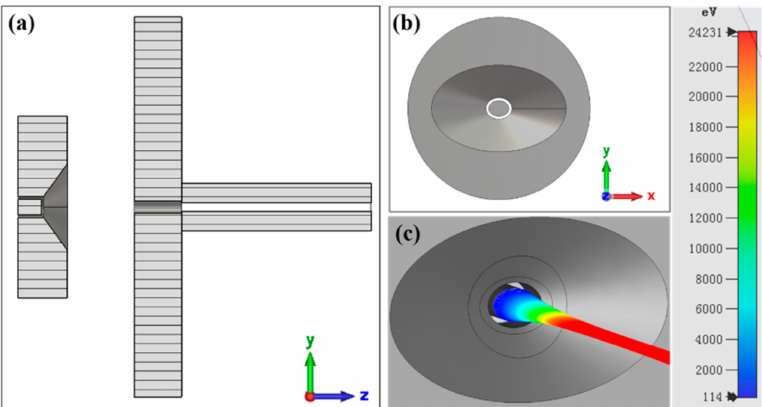
Figure 1. The CST model of the sheet-beam electron gun: ( a ) the cross section of the model, ( b ) the front view of the cathode and focus electrode, and ( c ) the beam formation with the elliptical focus